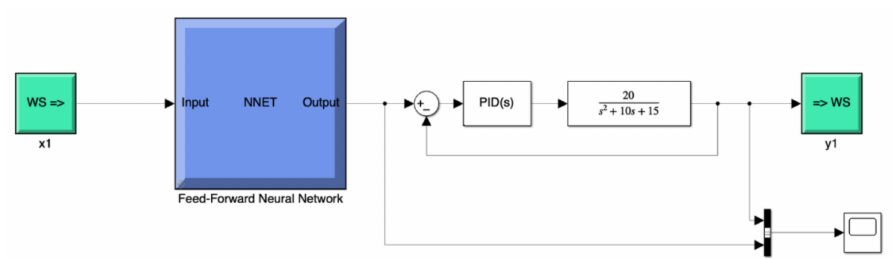
Figure 20. Dynamic machine model in the SIMULINK environment, closed